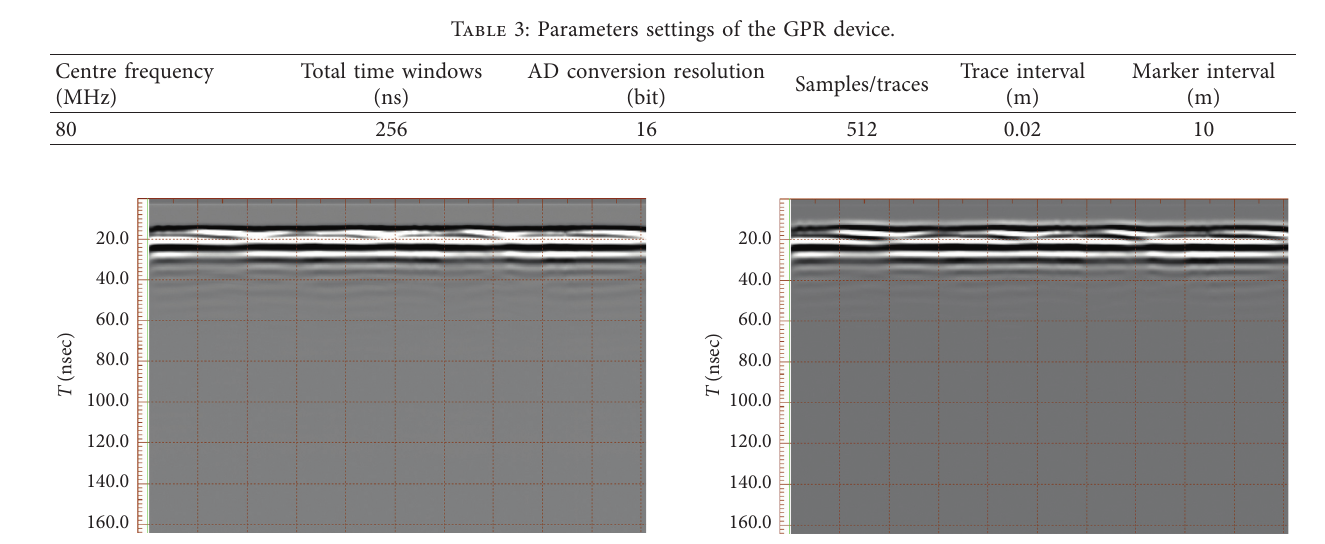
Figure 8: Radar image of the GPR raw data. Figure 9: Radar image after the vertical band-pass filtering in time domain.